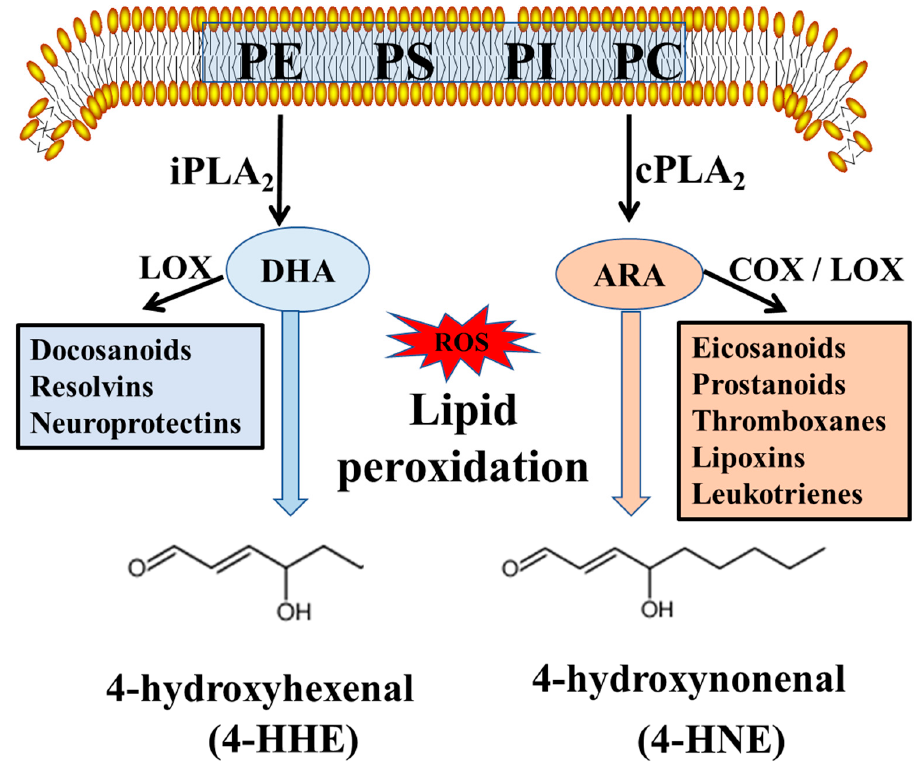
Figure 6. Pathways depicting release of DHA and ARA by cPLA 2 and iPLA 2 , respectively, and subsequently metabolism to docosanoids and eicosanoids by cyclooxygenase (COX) and lipoxygenase (LOX), as well as peroxidation to form 4-HHE and 4-HNE. Endogenous levels of 4-HHE and 4-HNE are present in all brain regions as well as in the heart and plasma. Maternal DHA was shown to increase the 4-HHE levels in specific brain regions without alteration of 4-HNE levels. These results are in agreement with our earlier study with cell model